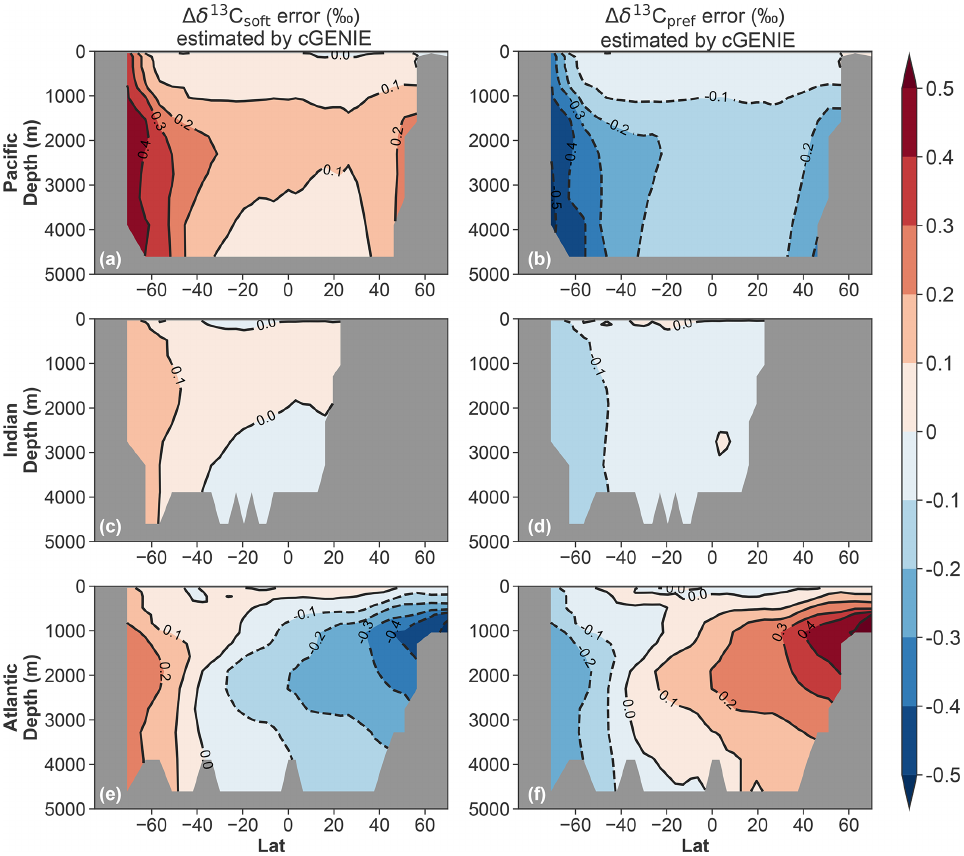
Figure 5. cGENIE early deglacial transient AOU error analysis for (cid:49)δ 13 C soft (a, c, e) and (cid:49)δ 13 C pref (b, d, f) . The anomalies are defined as 15ka minus 17.2ka. The errors are defined as AOU-based anomaly minus explicitly simulated anomaly.